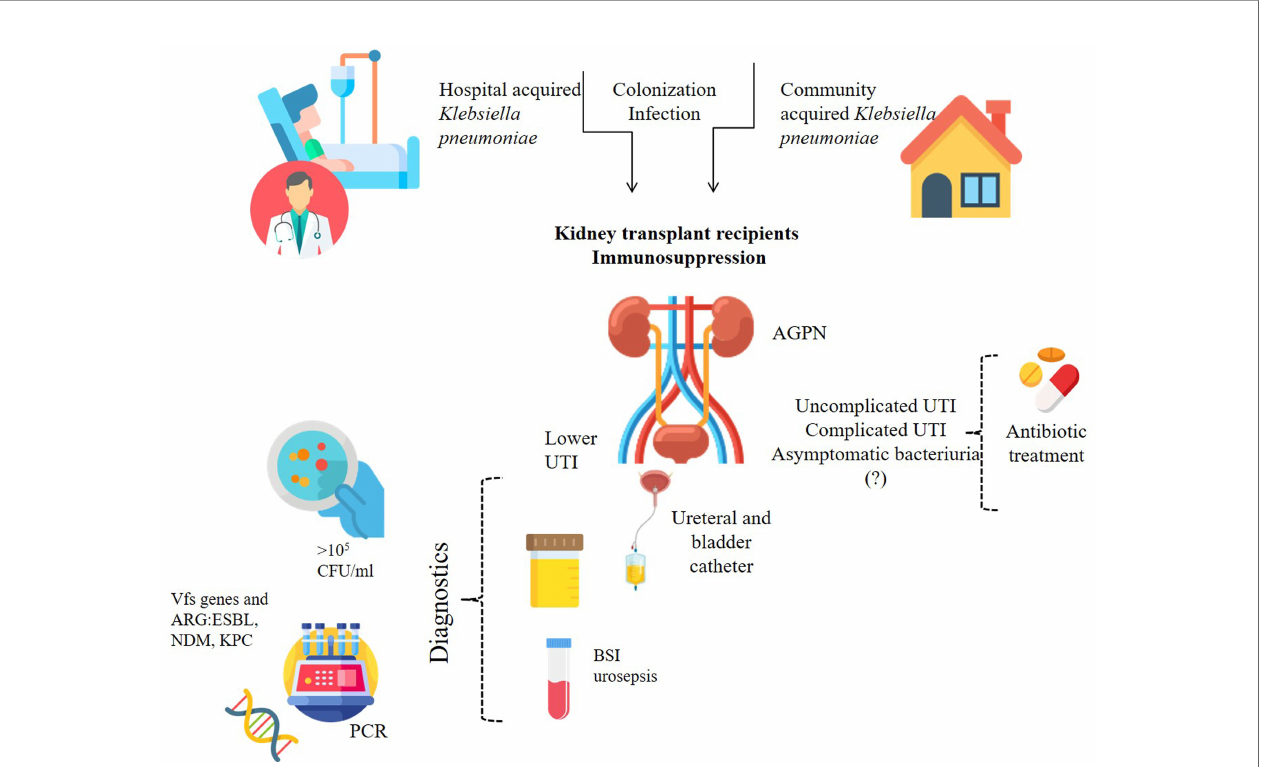
FIGURE 2 | Risk factors related to K. pneumoniae for renal transplant recipients. BSI, blood stream infection; Vfs, virulence factors; ARG, antibiotic resistance gene/s; ESBL, Extended-spectrum b -lactamases; NDM-1, New Delhi metallo- b -lactamase 1; KPC,